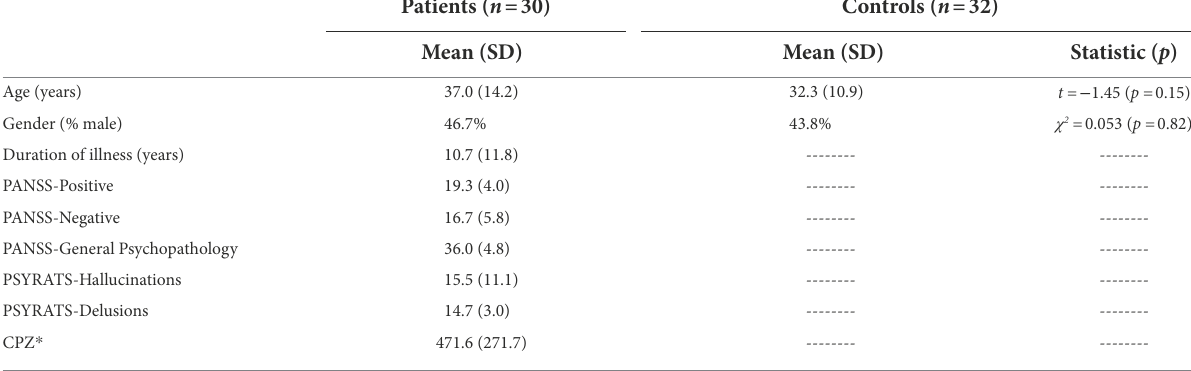
TABLE 1 Sample demographics and clinical status of